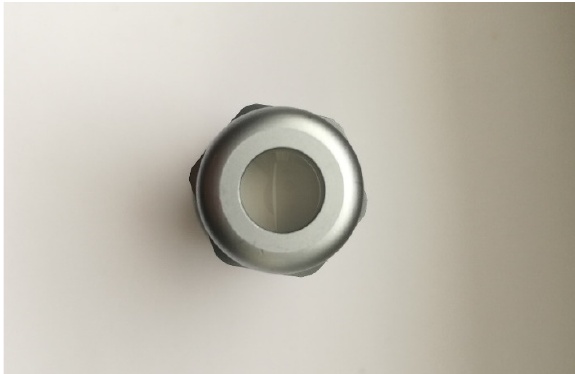
Figure 13. Aviation plug after glue filling.